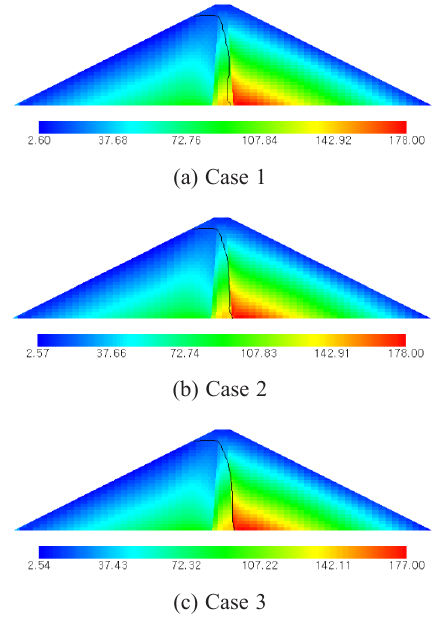
Fig. 10. Final phreatic line for each case